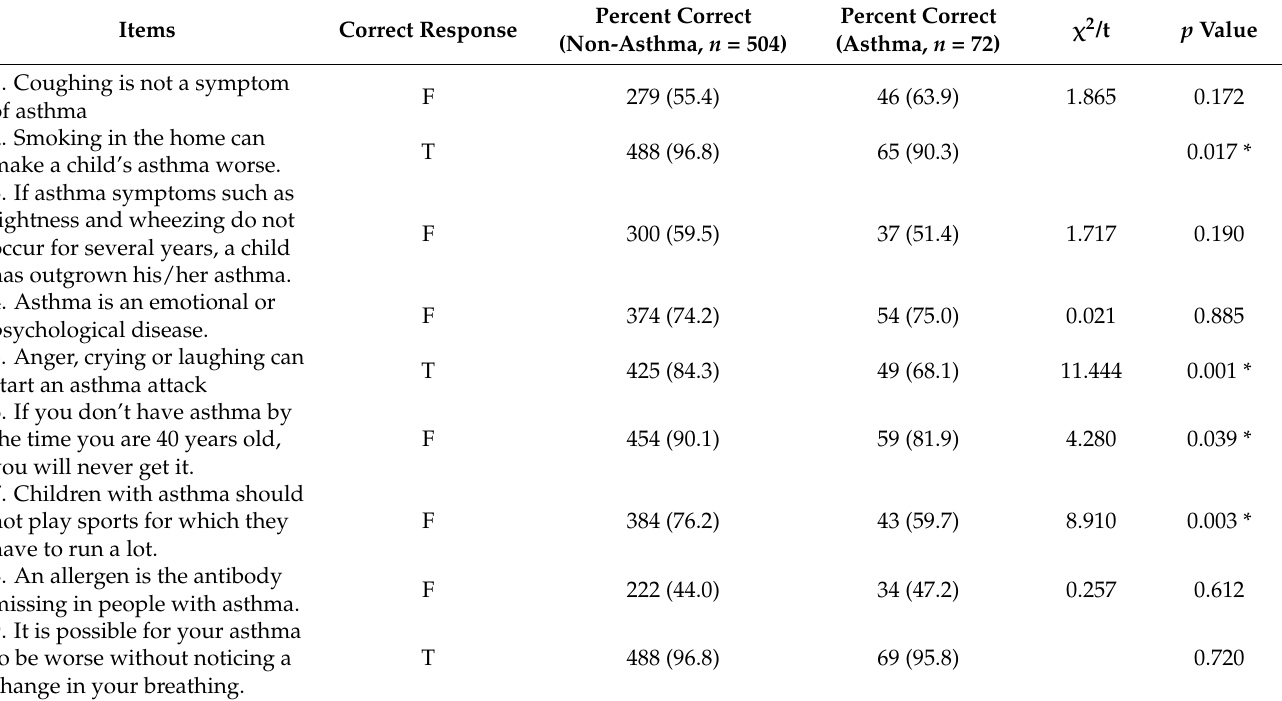
Table 4. Comparison of correct response rates for the Asthma Knowledge Questionnaire items between the asthma and non-asthma